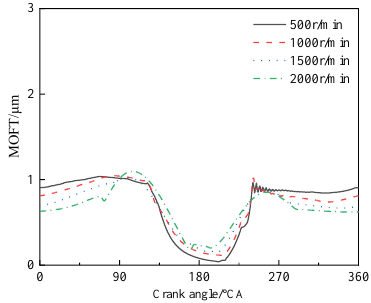
Figure 18. MOFT in different rotation speed.